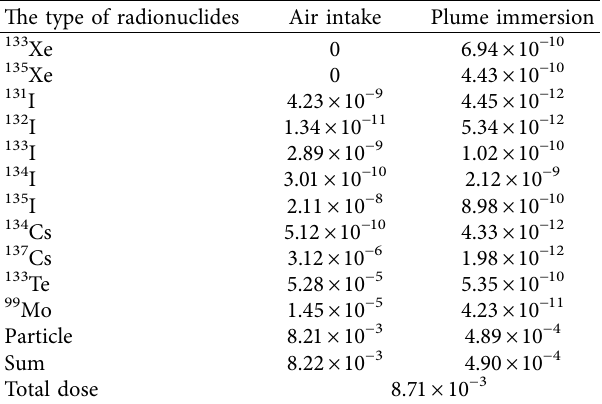
Figure 17: Radionuclide distribution rotating 90 ° clockwise at the eastern break.